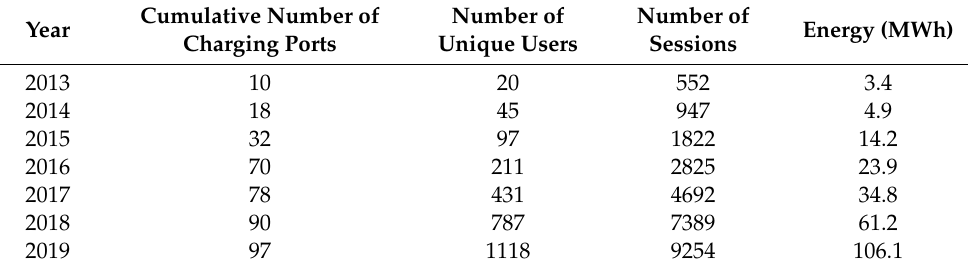
Table 1. Summary of the usage of charging stations.